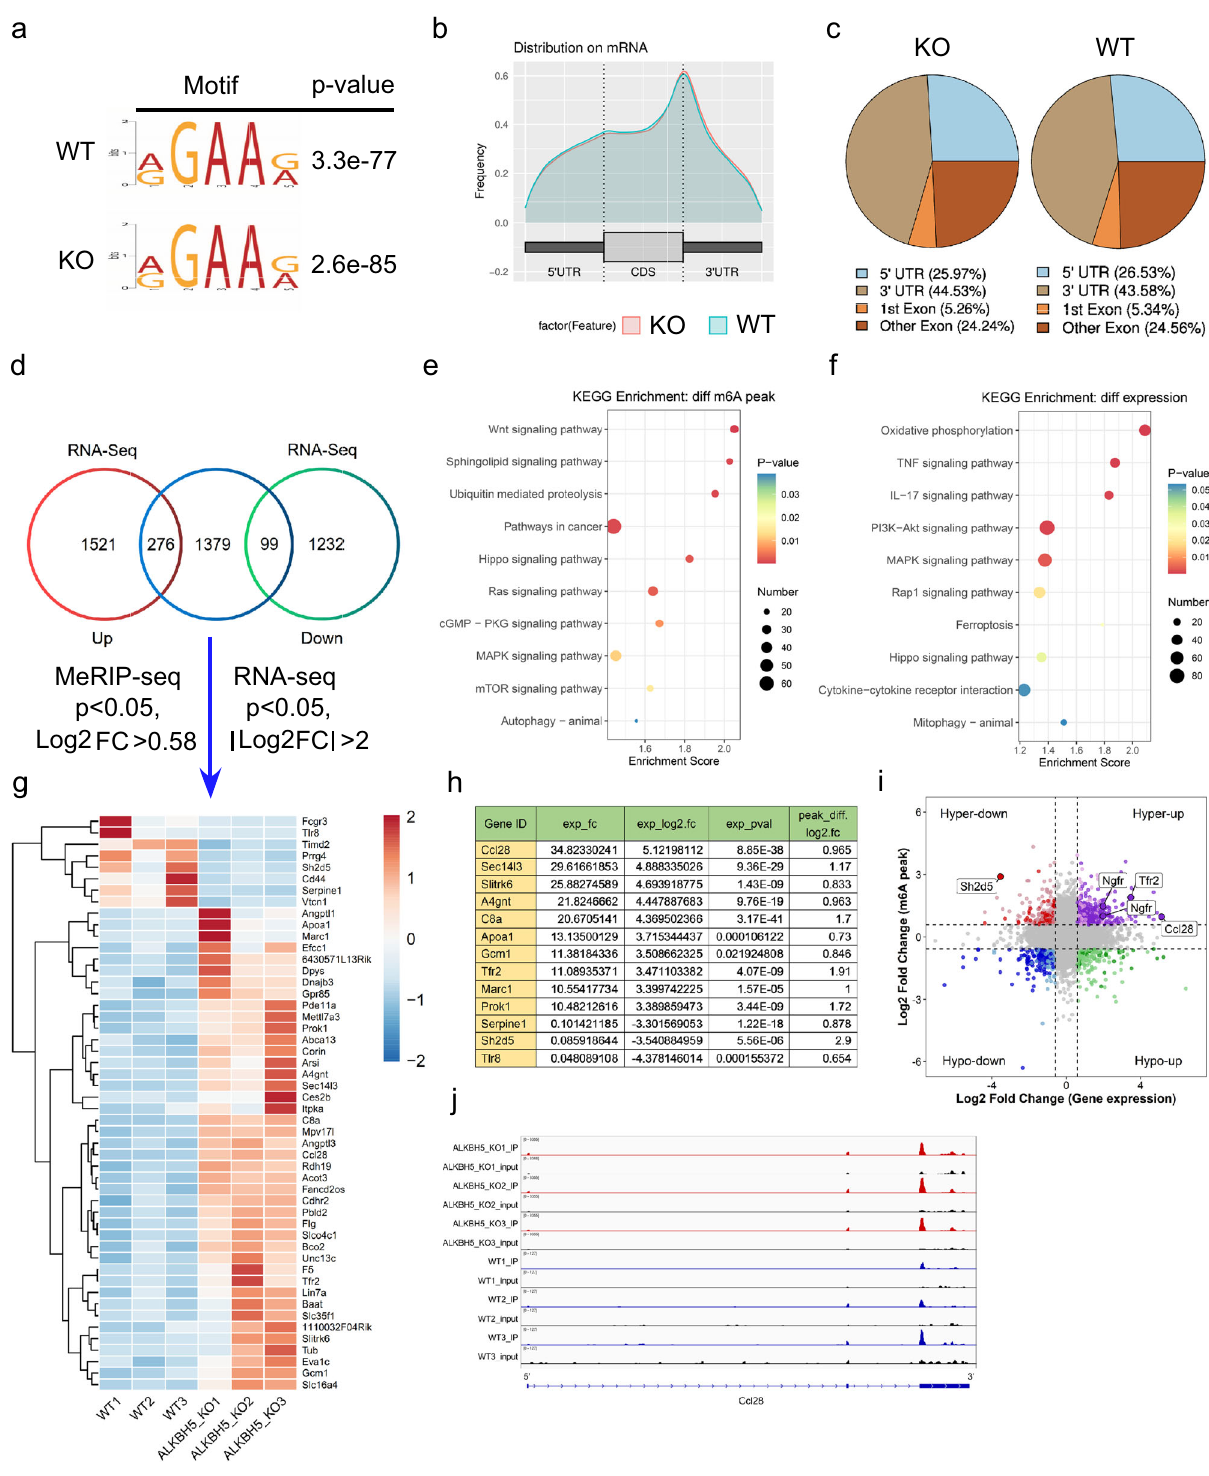
Fig. 4 | Characterization of m6A modi fi cation and gene expression changes between the Alkbh5- KO and WT mice. a Predominant motif identi fi ed with m6A- seq peaks in IRI-WT group or IRI-KO group. Motif enrichment p -value was calcu- latedbasedonFisher ’ sExactTest. b Distributionofm6ApeaksacrossmRNAinIRI- WT group and IRI-KO group. c Pie graphs of m6A peak distribution in indicated regionsinIRI-WT group and IRI-KO group. d Venn diagrams show 276 upregulated expression genes and 99 downregulated expression genes with m6A peak change inIRI-KOgroupcomparedwithIRI-WTgroup. e , f KyotoEncyclopediaofGenesand Genomes (KEGG) enrichment analysis correlated with different expression genes and different m6A peak genes. KEGG enrichment p -value was calculated based on